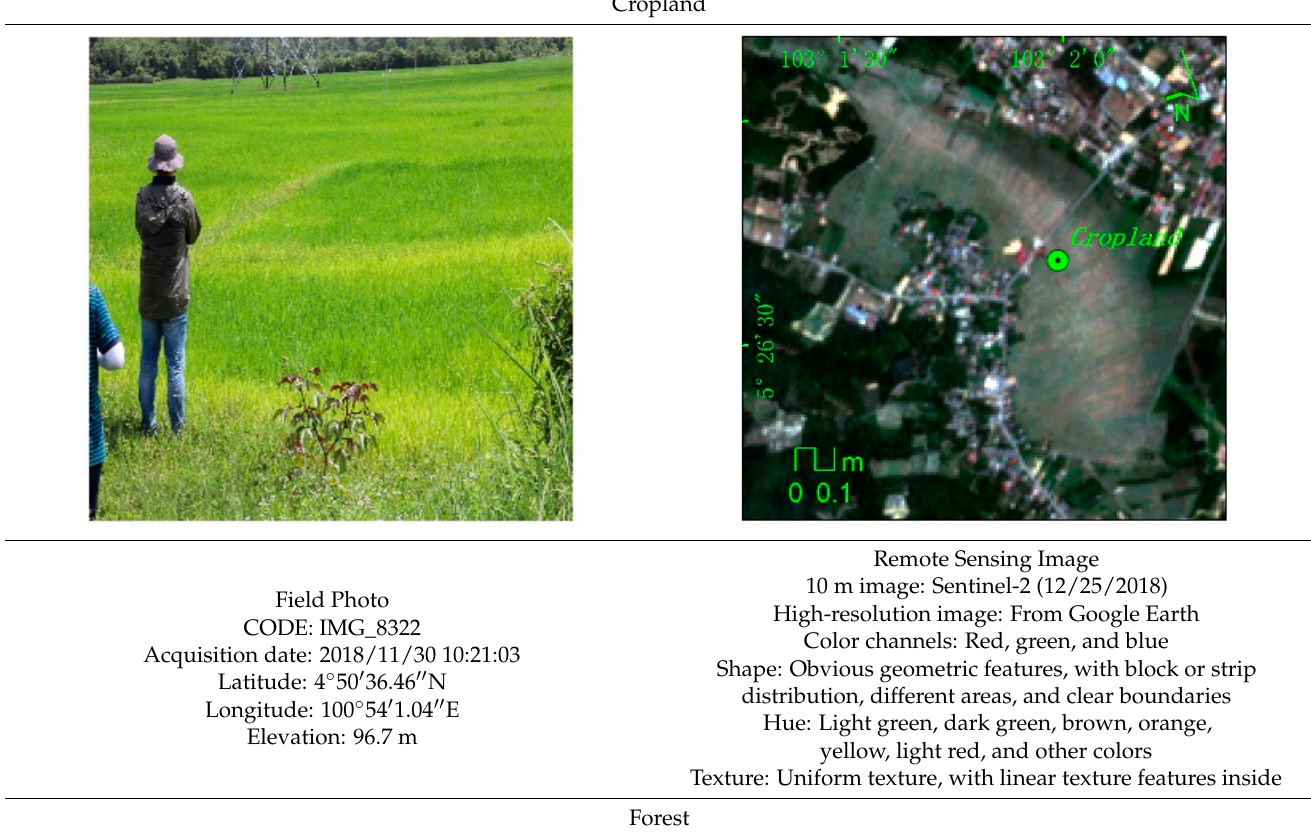
Table A1. Interpretation of the field photos and the remote sensing images of each class. Cropland